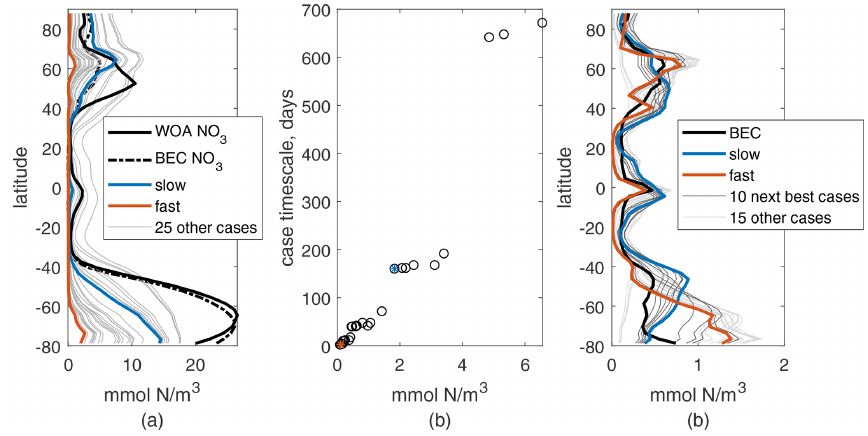
Figure 2. Annual and zonal mean of surface N (a) and P (c) for 27 parameter choice cases from the 10th year of simulation. Values for the two chosen cases are shown in blue and orange. Annual and zonal mean references are shown by the thick black lines: nitrate from the World Ocean Atlas observations and from the BEC model in the same physics (dashed); total plankton mass from the BEC model. (b) Case timescale values vs. global annual-mean N (black circles); the two chosen cases are marked with blue and orange stars.